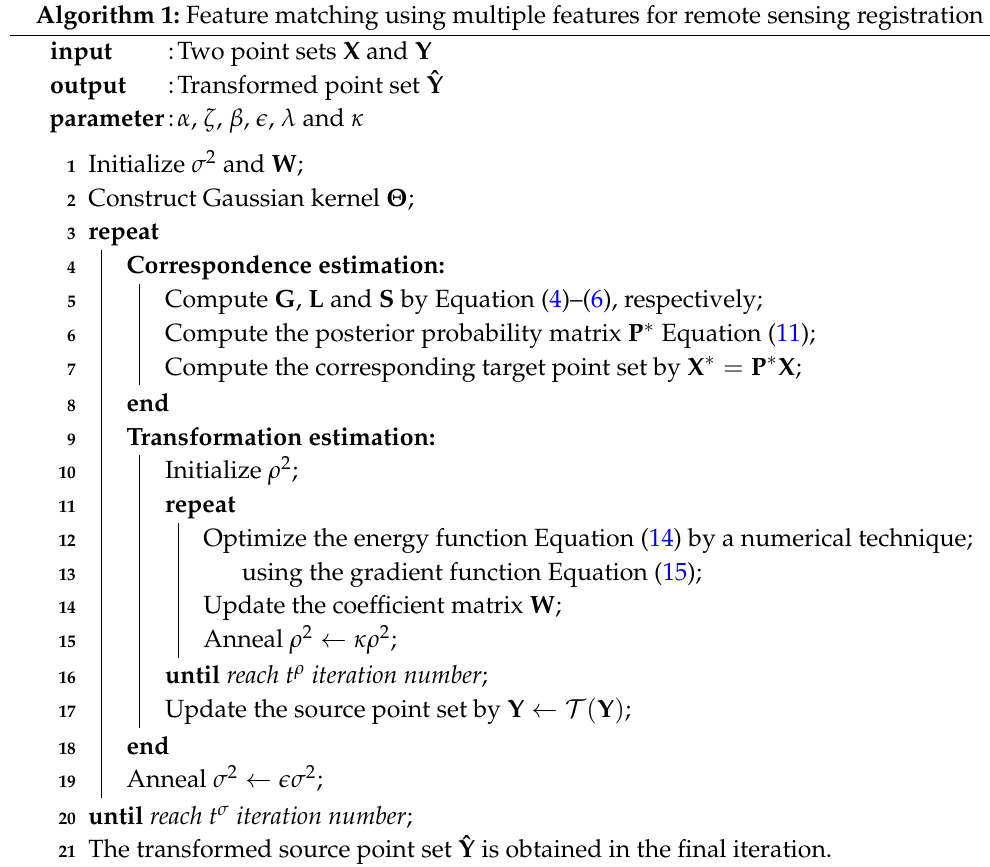
Algorithm 1: Feature matching using multiple features for remote sensing